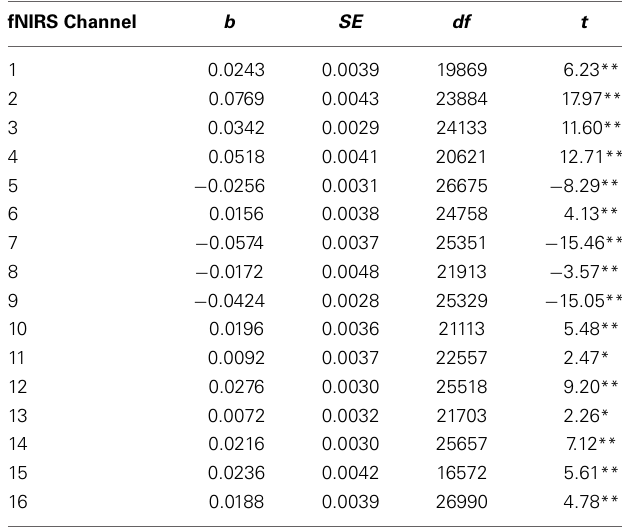
Table 5 | Multilevel analyses comparing oxy-Hb levels for participants who were matched for high accuracy ( N =